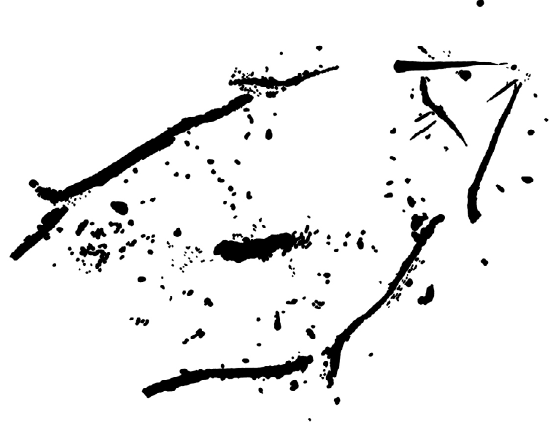
Figure 5. Canada do Inferno Rock 26, Côa Valley, Portugal. Deer depiction. Tracing: Fernando Barbosa, assisted by Manuel Almeida and António Martinho Baptista.